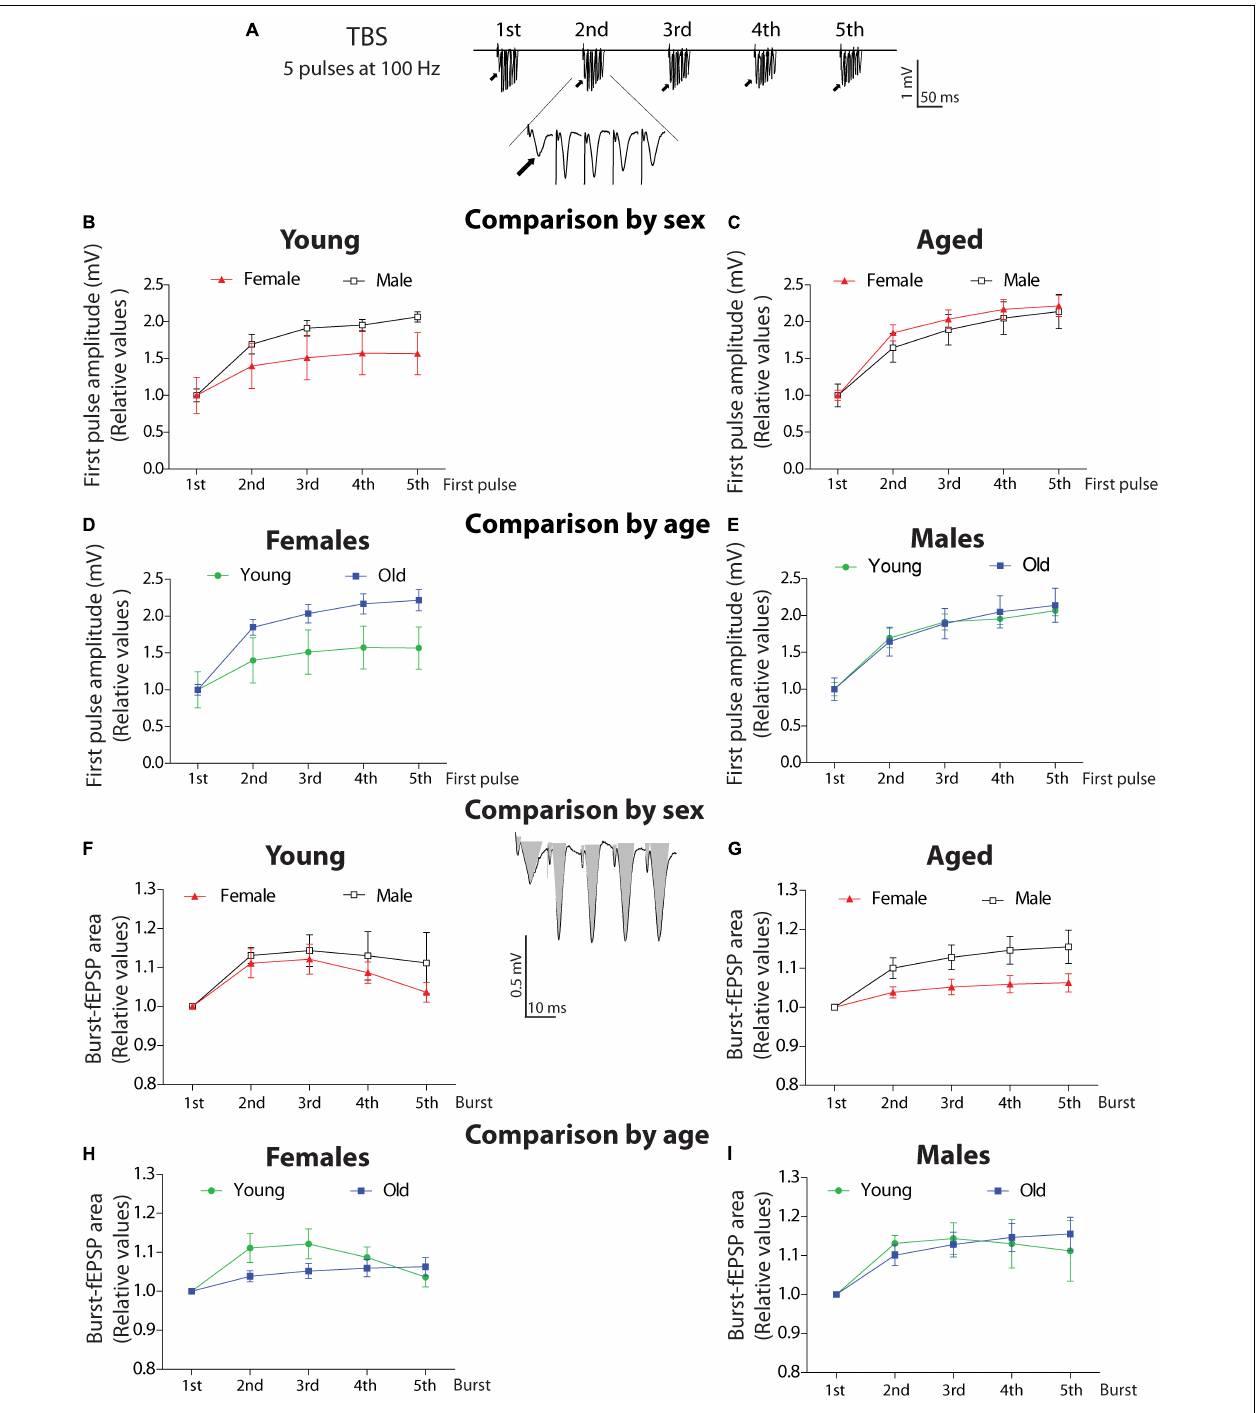
FIGURE 6 | Analysis of burst activity in young and aged degus. (A) TBS scheme including five bursts (scale: 1 mV, 10 ms). (B–E) Analysis of the first pulse amplitude. Comparison by sex. The first amplitude of every burst was normalized and compared in young (B) or aged (C) female and male degus. Comparison by age. The first amplitude of every burst was normalized and compared in young and aged female (D) or male degus (E) . (F–I) Analysis of fEPSP area. Comparison by sex. Total evoked fEPSP area induced by burst was measured as shown in gray (scale: 0.5 mV, 10 ms). The 2nd, 3rd, 4th, and 5th burst areas were normalized to the area of the 1st burst, compared in young (F) or aged (G) female and male degus. Comparison by age . The fEPSP areas in young and aged female (H) or male degus (I) . Each symbol corresponds to data from the sex-age treatment group, represented as the mean ± SEM (21 slices from n = 7 young , 27 slices from n = 9 young , 15 slices from n = 5 aged , and 21 slices from n = 7 aged degus). Two-way ANOVA was used to calculate the differences, including the bursts, sex, or ♀ age, as factors when ♂ ♀ ♂